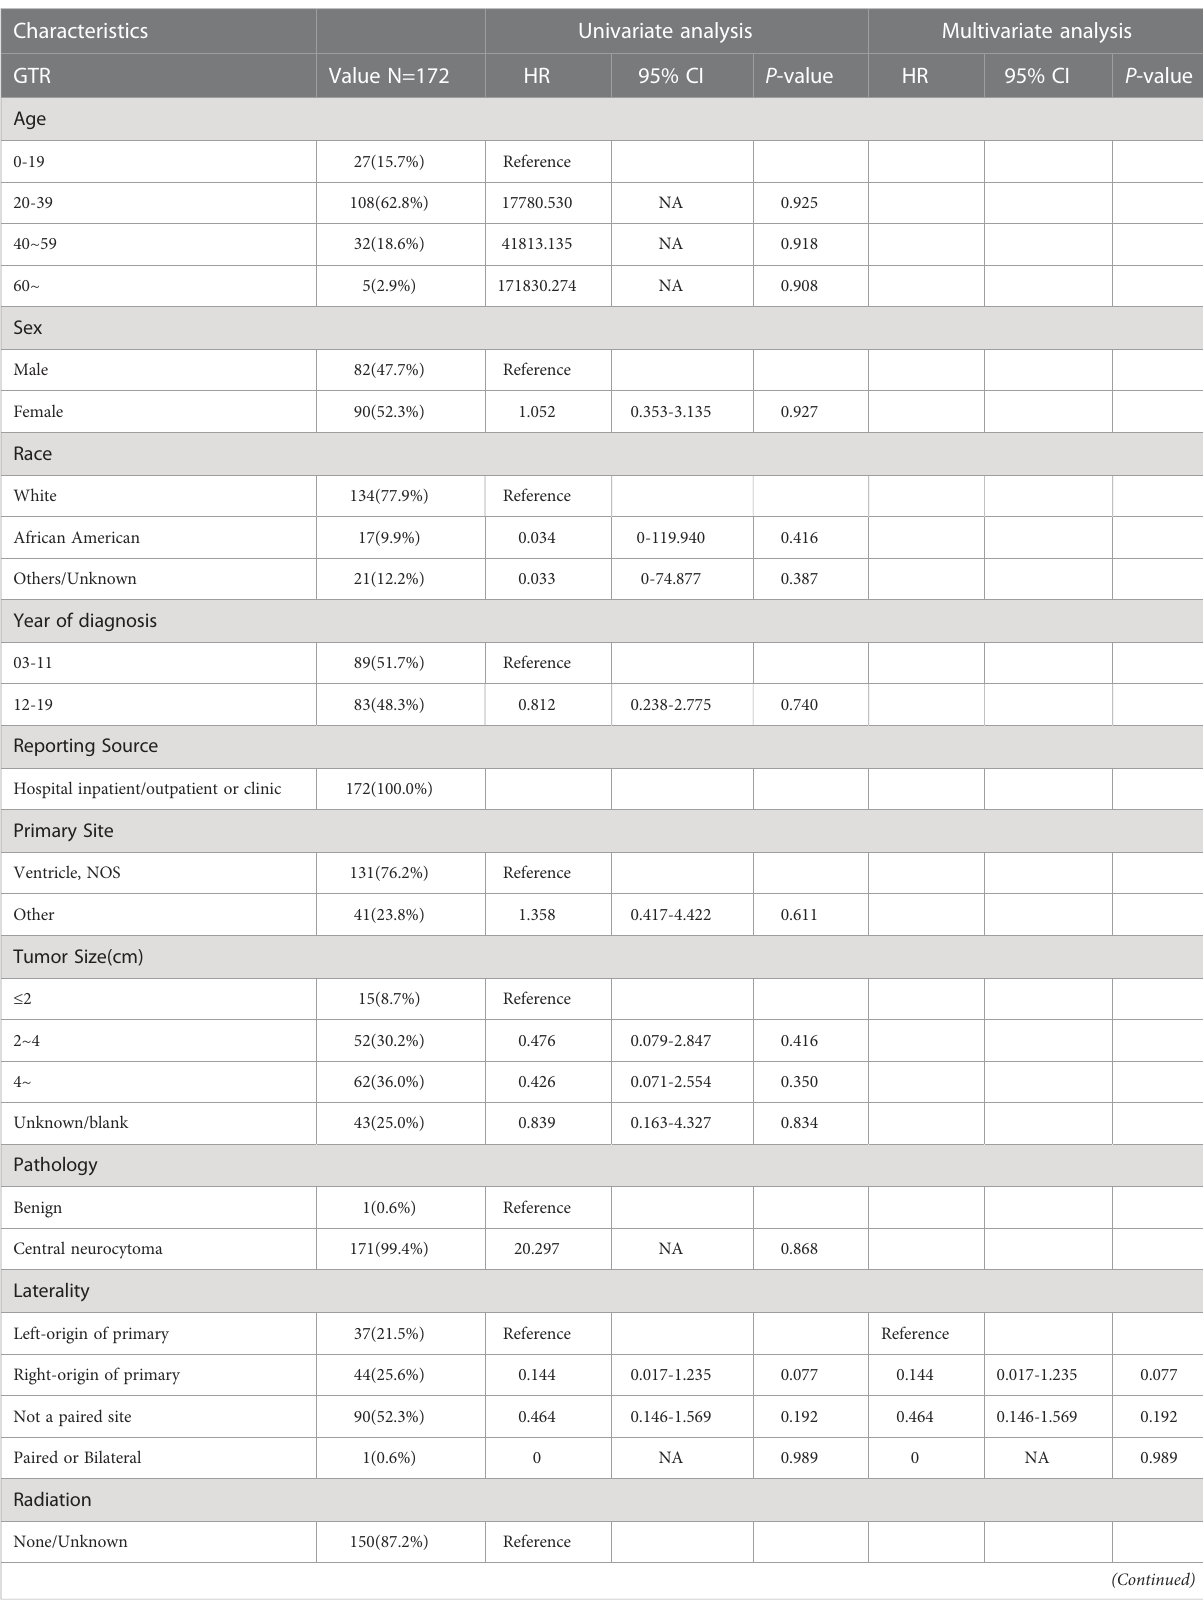
TABLE 2 The median overall survival (OS) of the gross total resection (GTR) was 81 (interquartile range (IQR): 40 – 128)